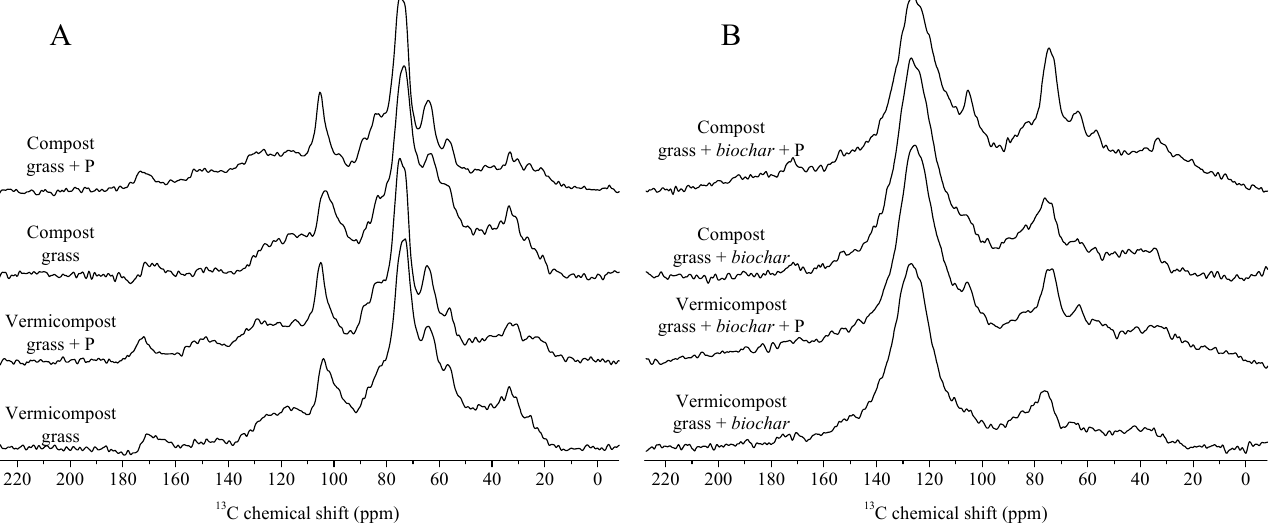
Figure 3. Solid state 13 C NMR spectra of the different compost and vermicompost obtained. Without biochar ( A ) and with biochar ( B ).